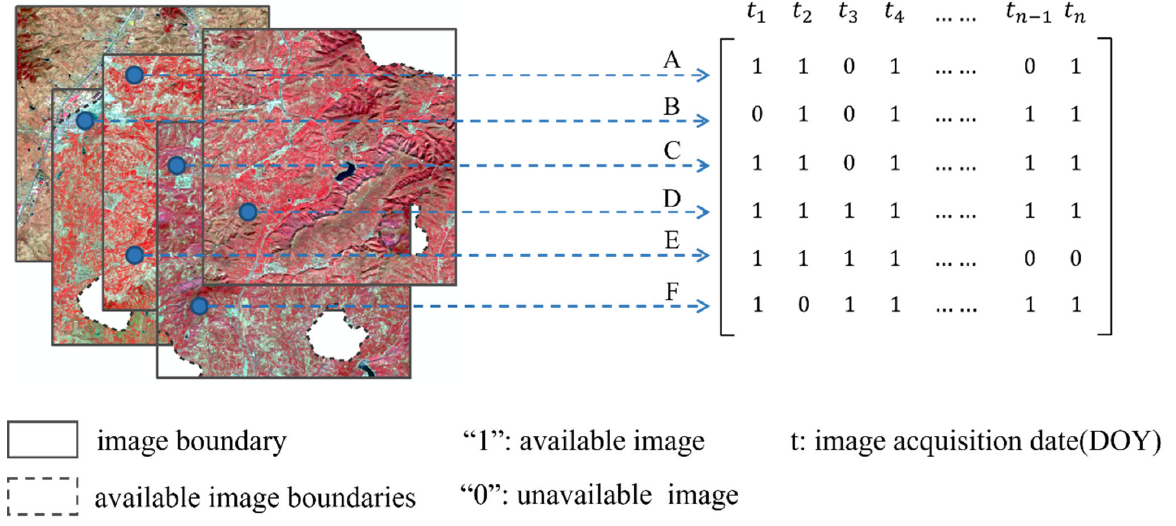
Figure 6. Schematic diagram of irregular time